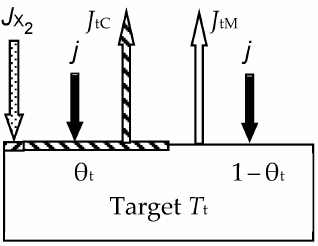
Figure 2. The flux densities on the target surface. Notations: J X2 is the flux density of X 2 molecules; J tM is the flux density of sputtered metal atoms; J tC is the flux density of sputtered M m X n molecules; j is the discharge current density; θ t is the fraction of the target surface covered by the compound fi lm.